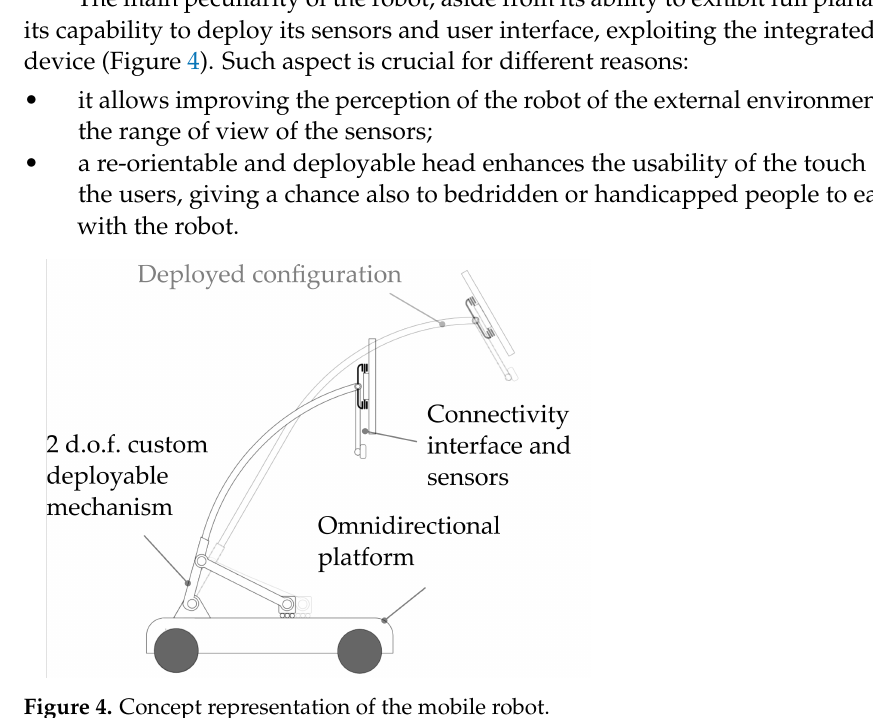
Figure 4. Concept representation of the mobile